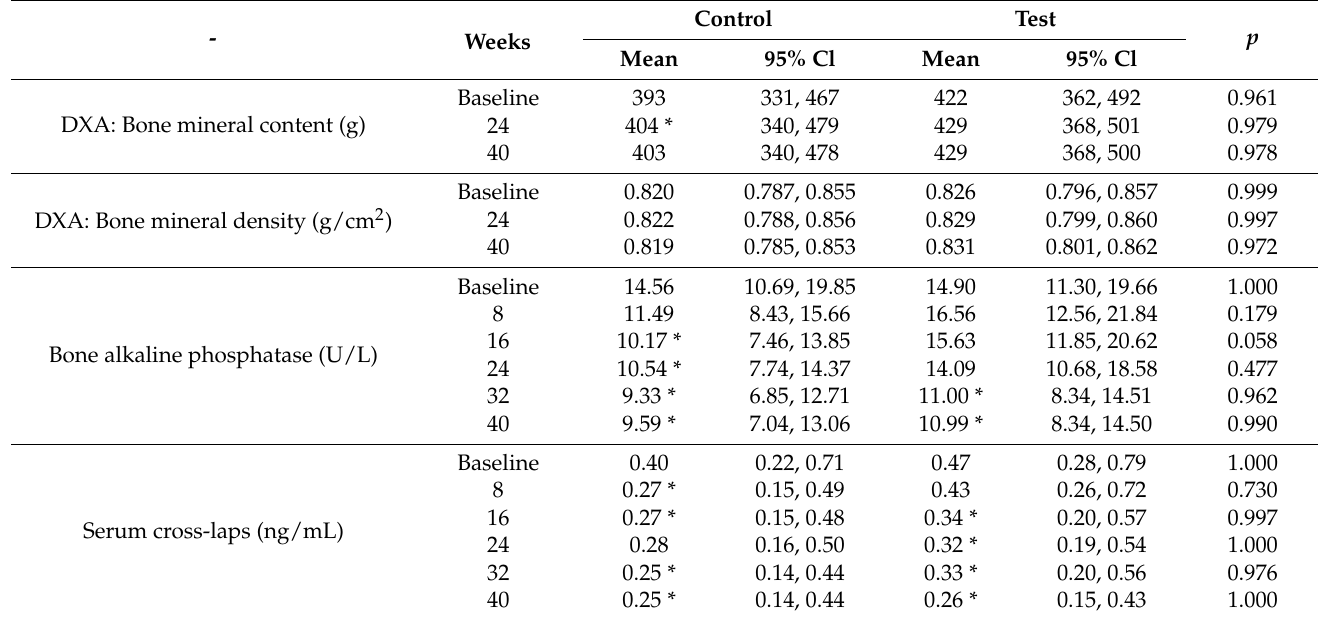
Table 5. Bone health measure values given as means and 95% confidence intervals (CI) for the control ( n = 8) and test ( n = 10) diet dog groups at baseline and at eight-week intervals. P values represent the comparison between diet groups at the sample collection time